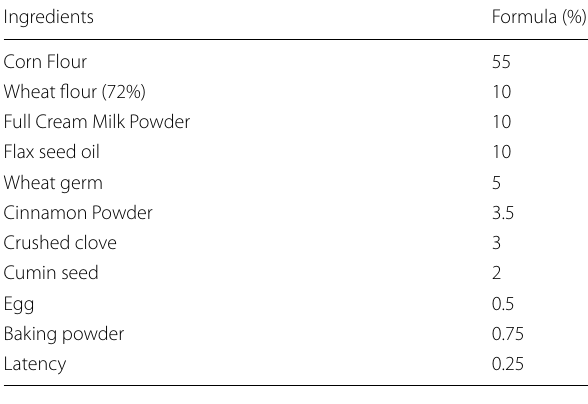
Table 1 Formula composition of Corn Rusk (percentage of